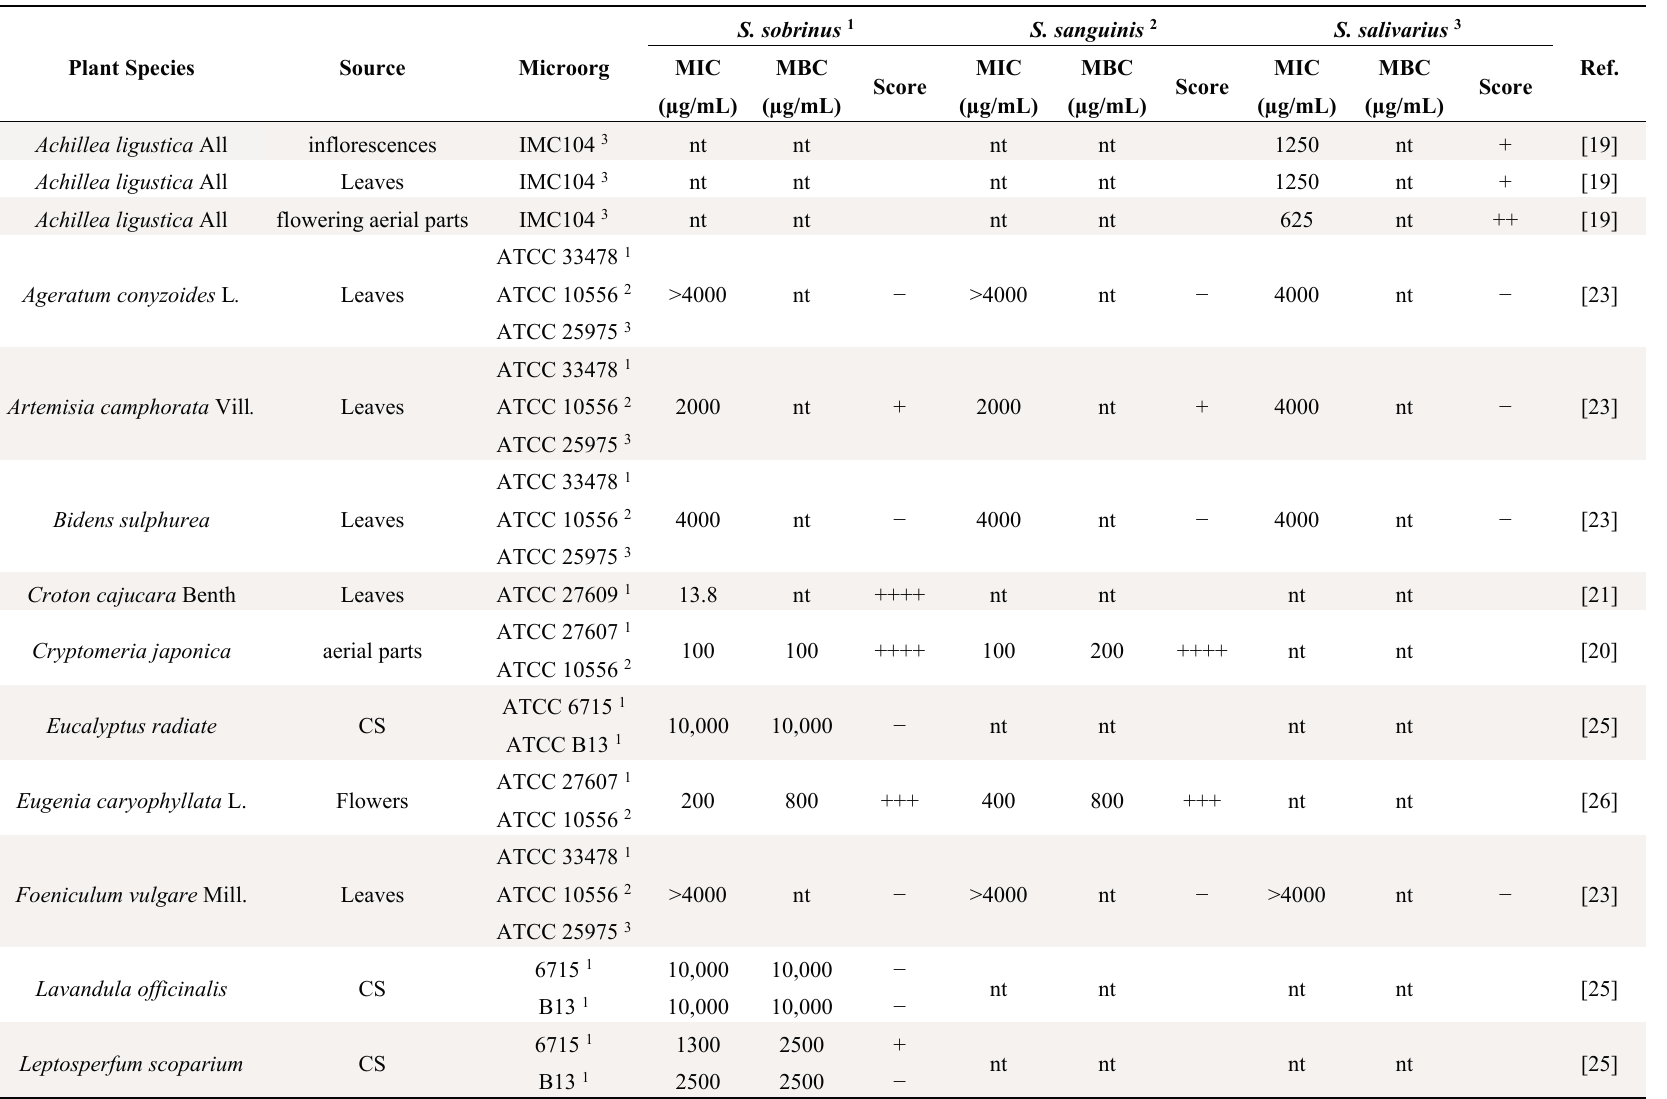
Table 2. In vitro antibacterial activity of essential oils against S. sobrinus , S. sanguinis and S. salivarius. Plant